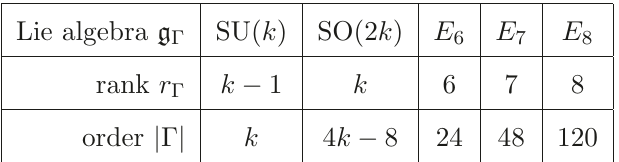
Γ for ADE subgroups Γ of | |